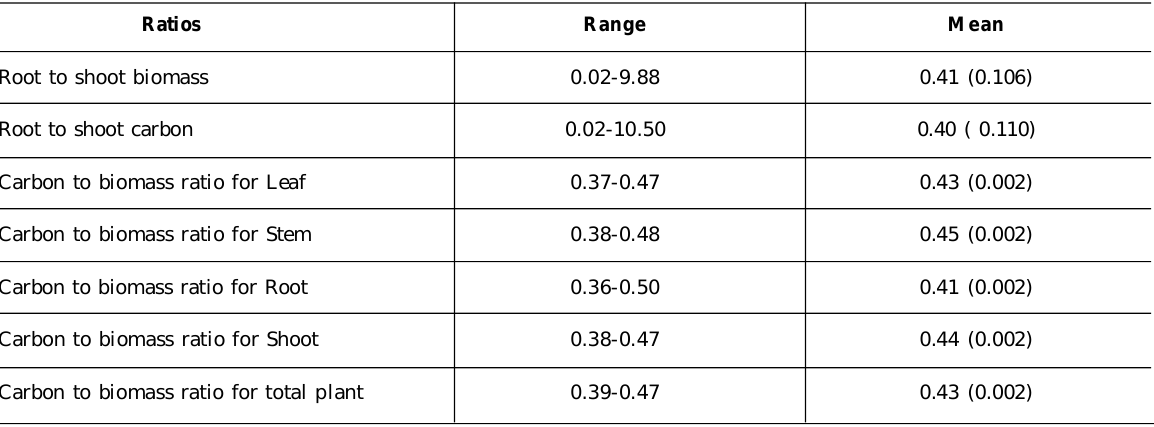
Table 4: Variations in different ratios related to carbon and biomass of different herbaceous plant components across the species in a tropical grassland at Varanasi, India. Values in the parentheses are ±1